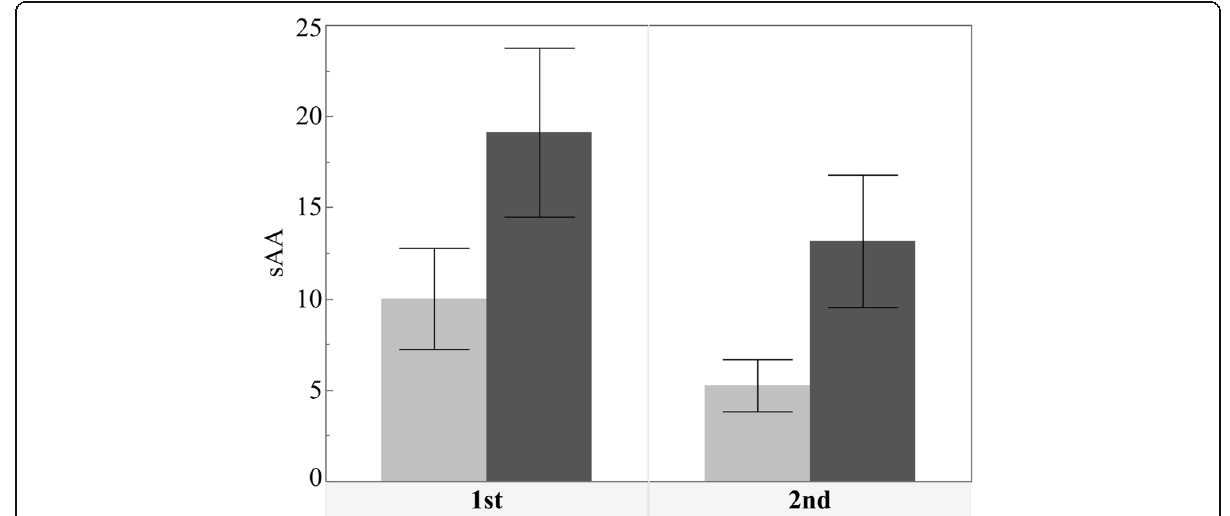
Fig. 1 Bar chart showing the mean sAA activity level before and after operation. A significant increase was seen in sAA after the operation ( p